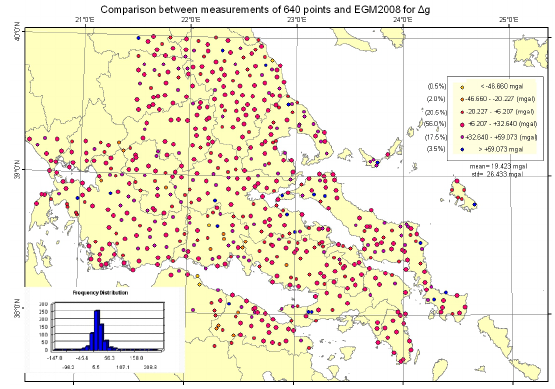
Figure 11: Geographical distribution of residuals between free-air gravity anomalies based on EGM2008 and terrestrial gravity data over 660 points in the Central